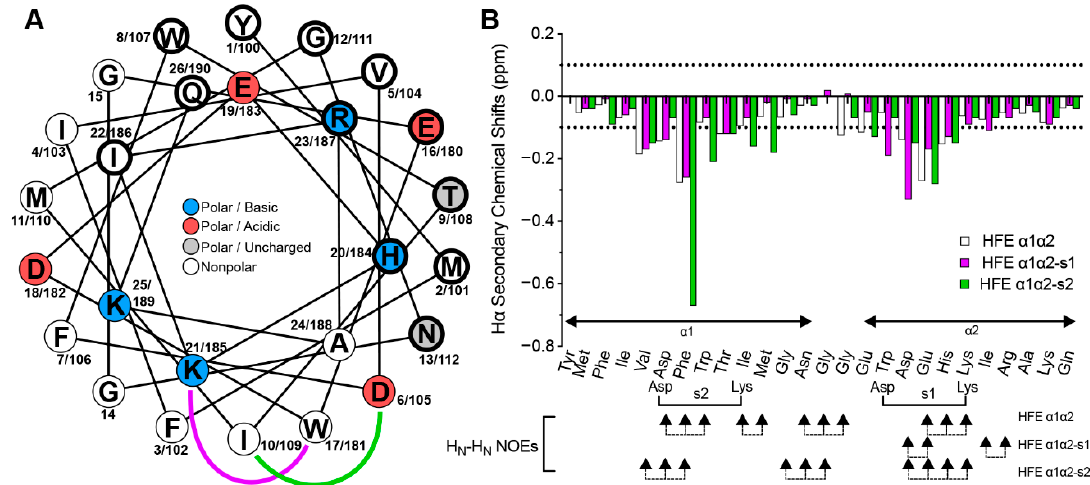
Figure 4. Design and structural analysis of HFE α 1 α 2 stapled analogues. ( A ) Helical depiction of HFE α 1 α 2 and stapled variants. Sidechain staple linkages are shown in purple (HFE α 1 α 2-s1, stapled between Lys 21 , and an Asp introduced at position 17) and green (HFE α 1 α 2-s2, stapled between Asp 6 and a Lys introduced at position 10). Residues on the interaction face with Tfr are shown by bold circles. ( B ) Comparison of the H α secondary chemical shifts for HFE α 1 α 2 and stapled analogues 1 and 2.